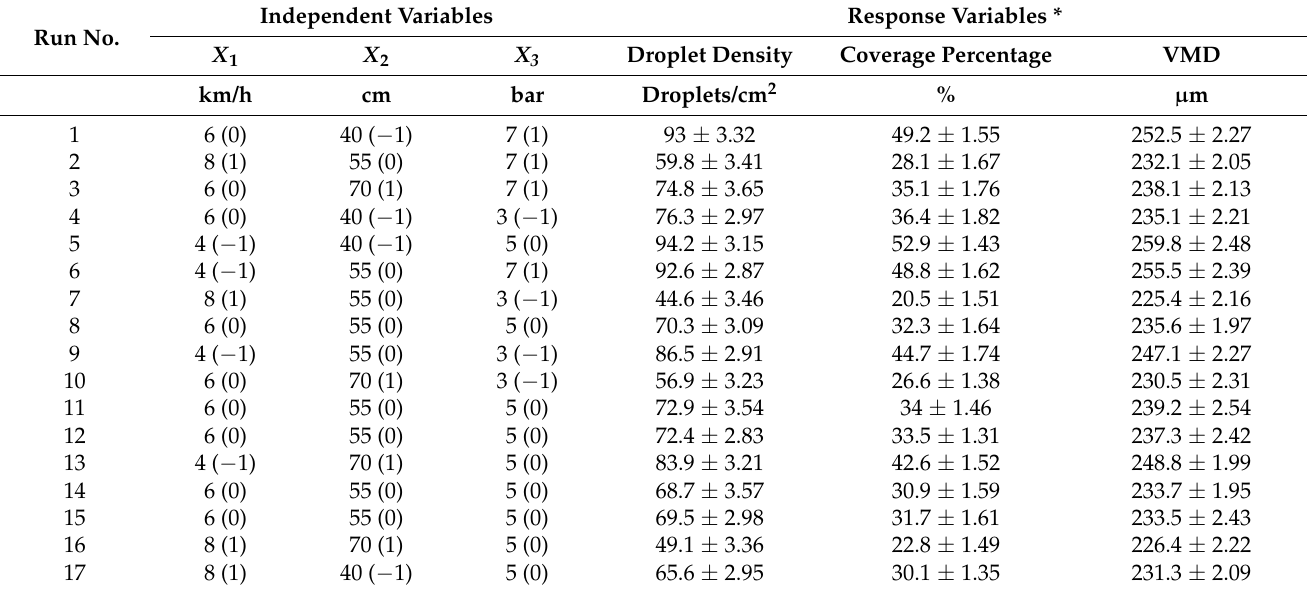
Table 3. Experimental values of the independent variables. Mean and standard deviation of the response